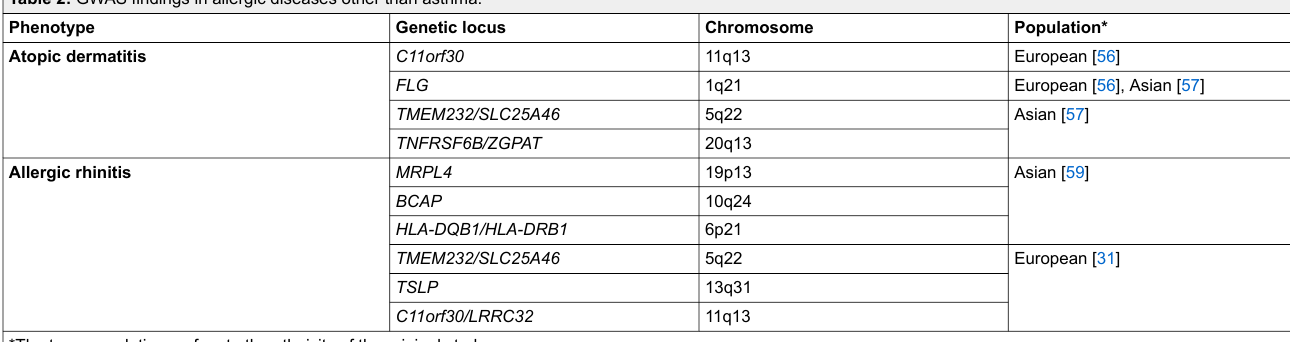
Table 2: GWAS findings in allergic diseases other than